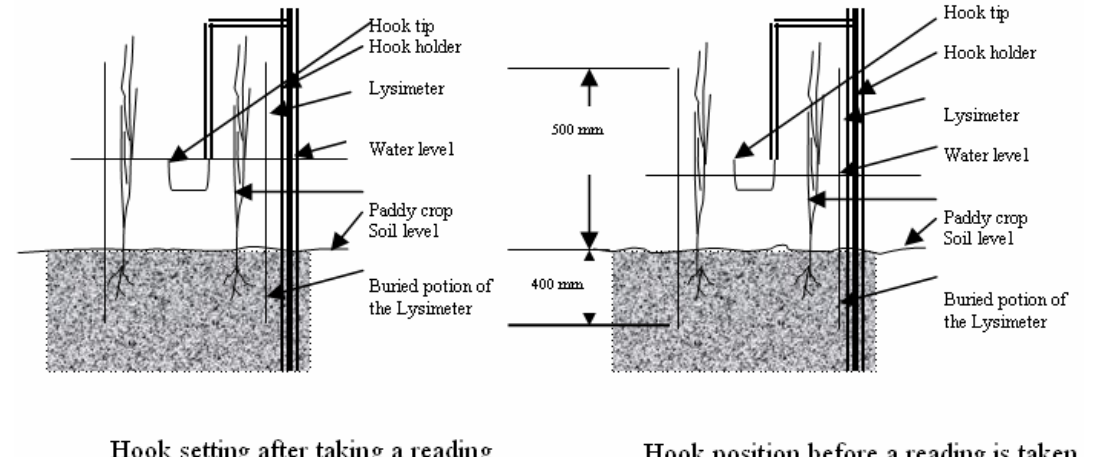
Figure 2: Cross sectional view of a lysimeter installed in a field